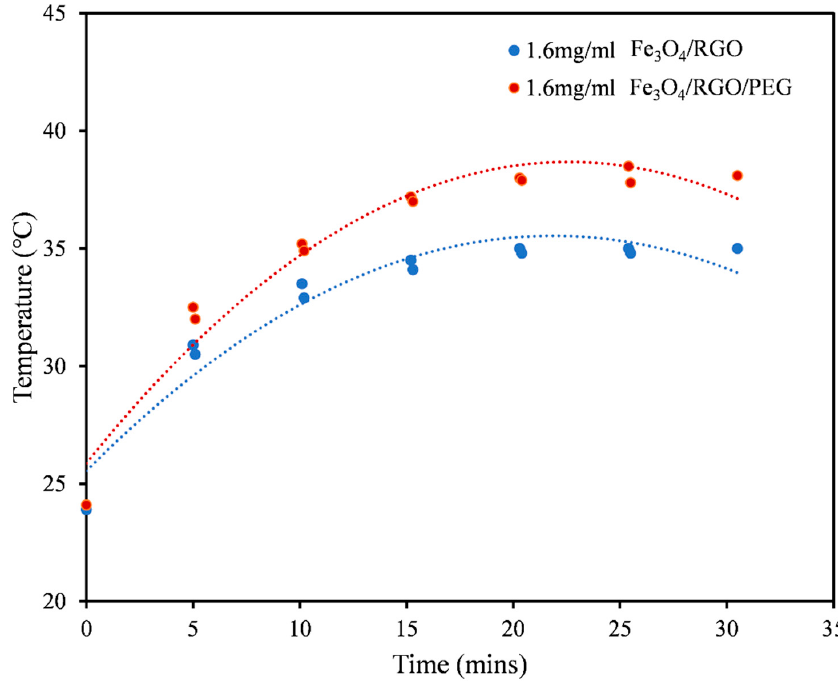
Figure 6. Heating profiles for 1.6 mg/mL Fe 3 O 4 /RGO (blue) and 1.6 mg/mL Fe 3 O 4 /RGO/PEG (red) in a 4.66 pH buffer at a magnetic field of 200 A.